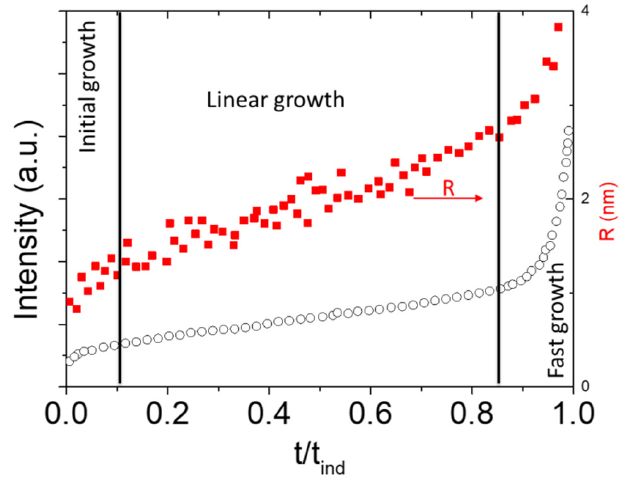
Figure 5. Scattering intensity of sol-gel growth during induction time with square symbol for radius and circle symbol for intensity. (Reprinted/adapted with permission from Ref. [53]. Copyright © 2023, Kluwer Academic Publishers).